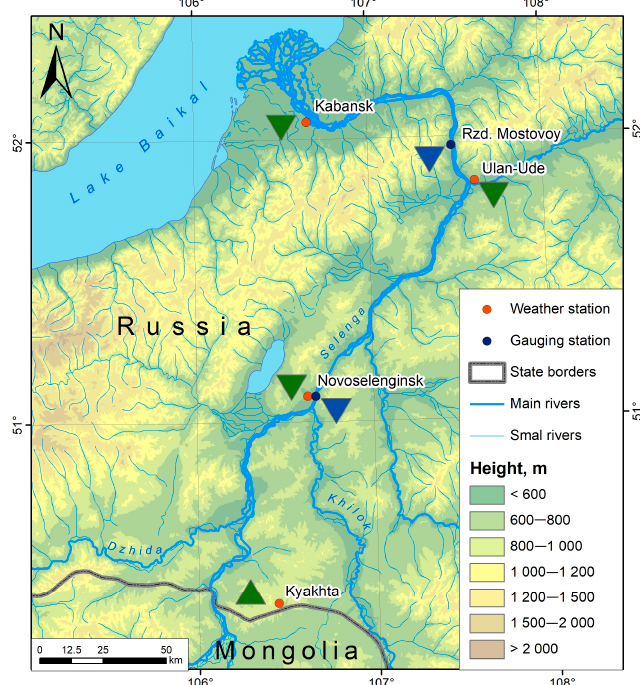
Figure 8. Summary of rainfall and runoff trends.